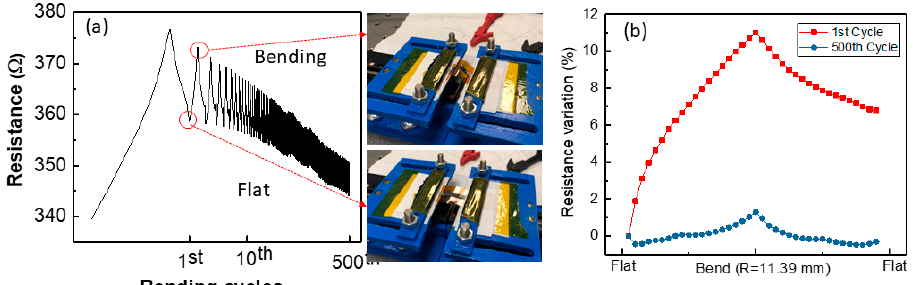
Figure 8. Cyclic bending of textile-based pH sensor ( a ) resistance monitoring of pH sensor until the sensor was bent up to 500 times, ( b ) comparison in pH sensor’s resistance variation between the first and 500th bending cycle when it was bent with a bending radius of 11.39 mm.